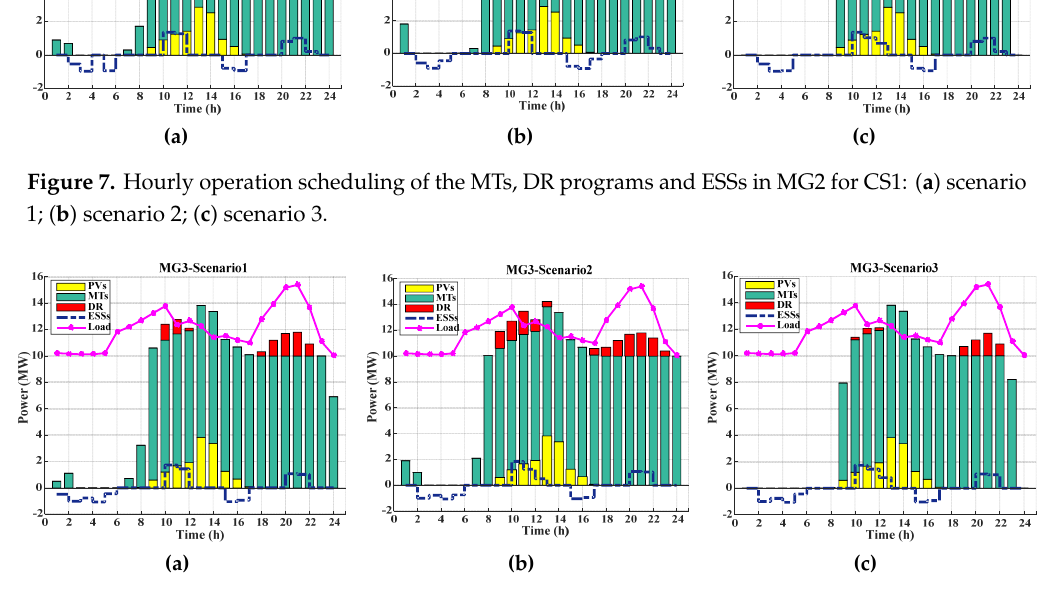
Figure 8. Hourly operation scheduling of the MTs, DR programs and ESSs in MG3 for CS1: ( a ) scenario 1; ( b ) scenario 2; ( c ) scenario 3.